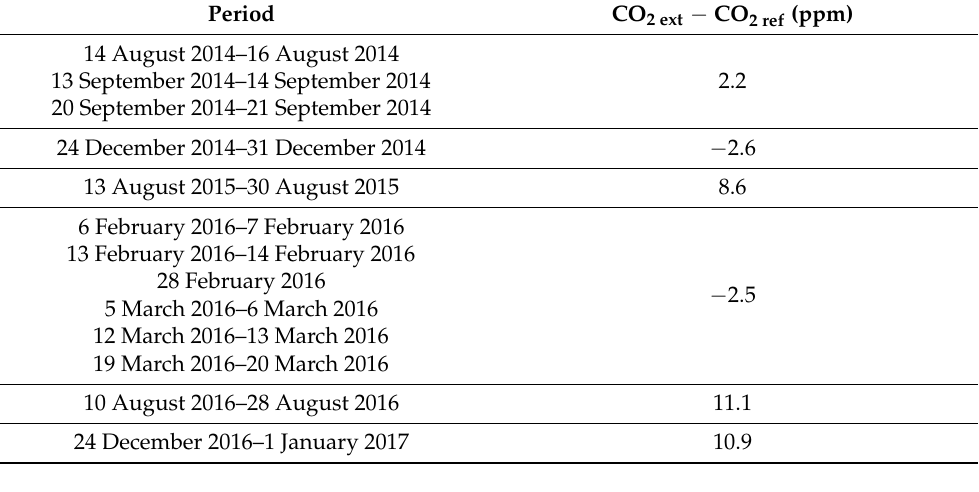
Table 2. Difference between the outdoor and the reference CO 2 concentration measurements, consid- ering their averages in periods when both records were available and the building was not occupied. Period